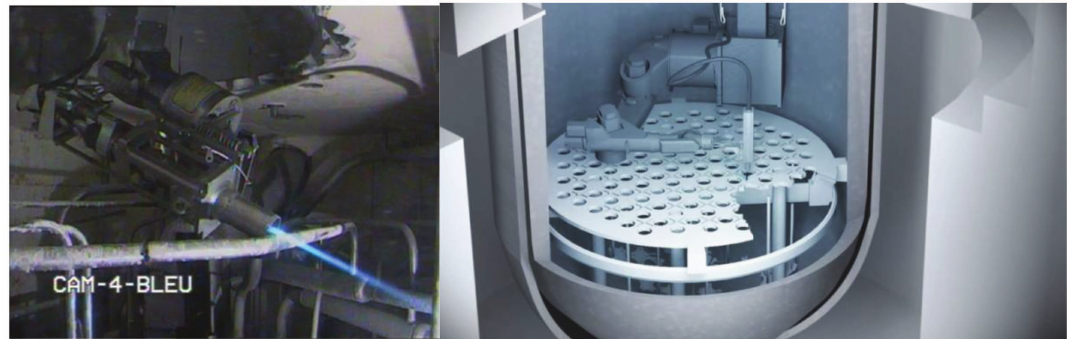
Fig. 5. Laser cutting technology applied to pipe in UP1 CEA facility and cutting and planned application of laser cutting technology in reactor environment (3D